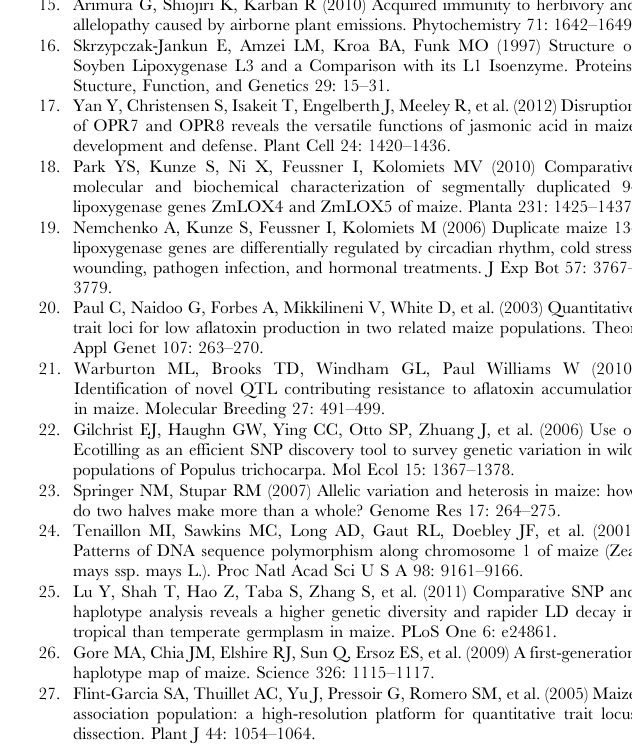
chromosome 1 based on the B73 reference genome (B73 RefGen_V2). Table S2 SNP genotypes for the 203inbred lines suc- cessfully sequenced for ZmLOX5 and their respective position on chromosome 5 based on the B73 reference genome (B73 RefGen_V2). (XLSX)